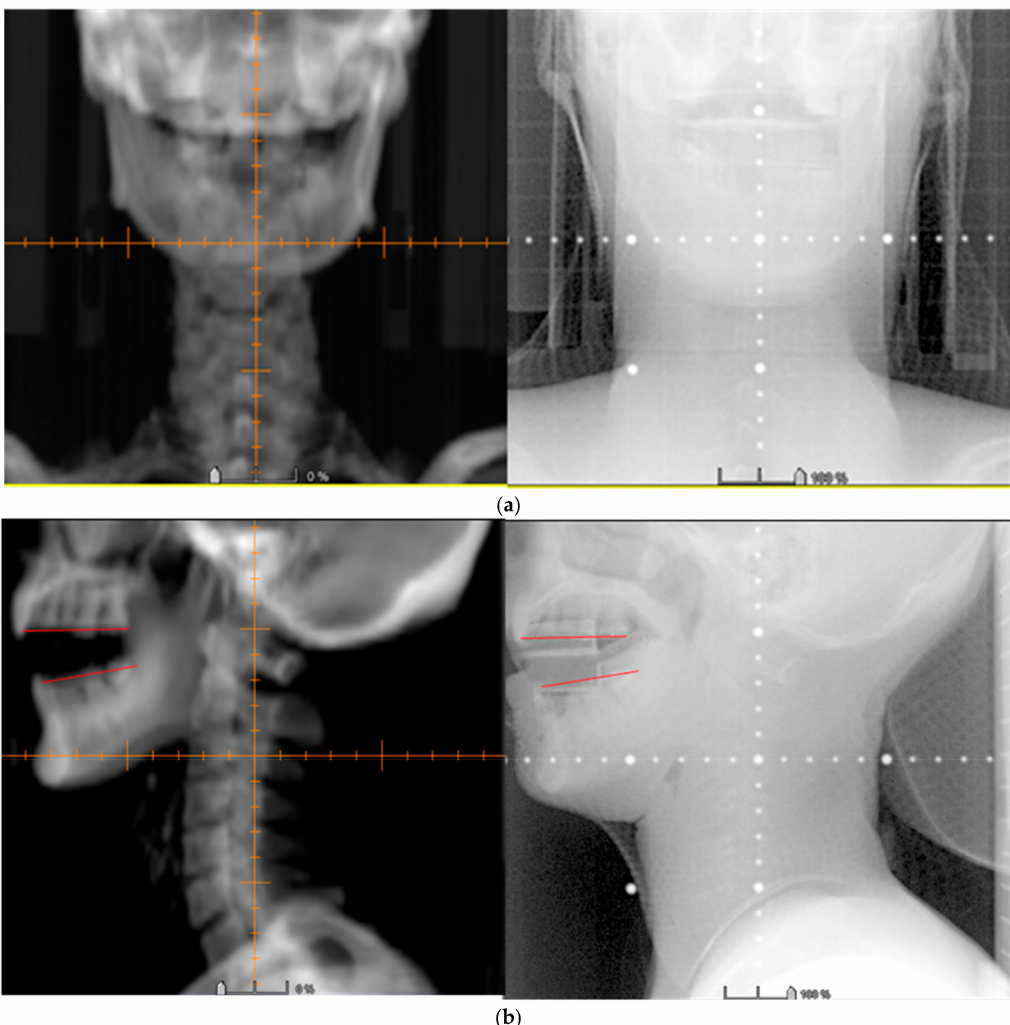
Figure 6. Imaging verification by port film images. Orthogonal ( a ) anterior-posterior; and ( b ) lateral images were obtained to verify isocentre placement for patients receiving head and neck RT. The port film images showed good alignment in the occlusal surface without